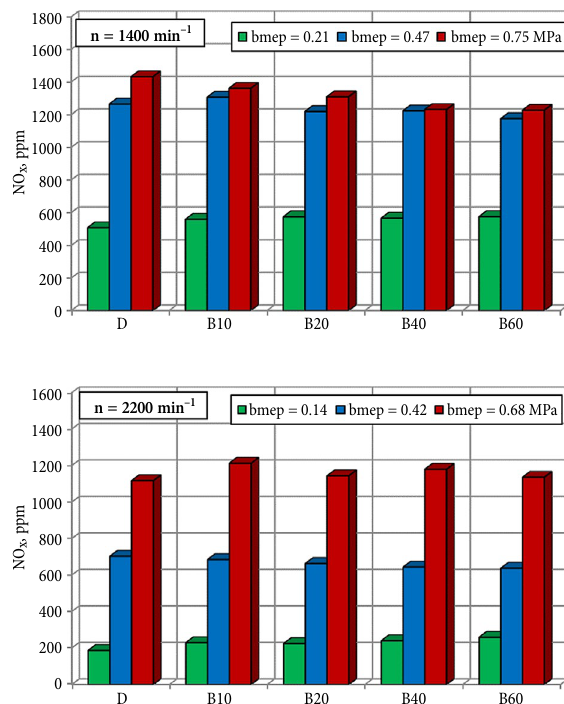
Fig. 8. Influence of the amount of RME in fuel on NO x